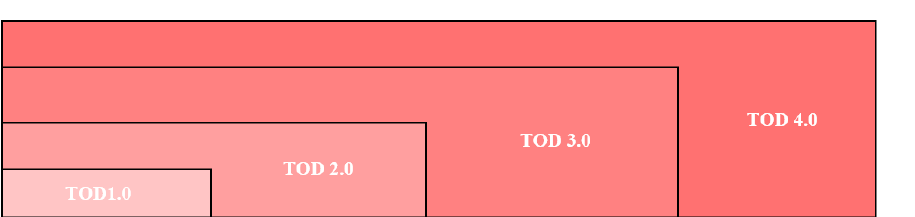
Figure 8. The selected chain from TOD 1.0 to 4.0.